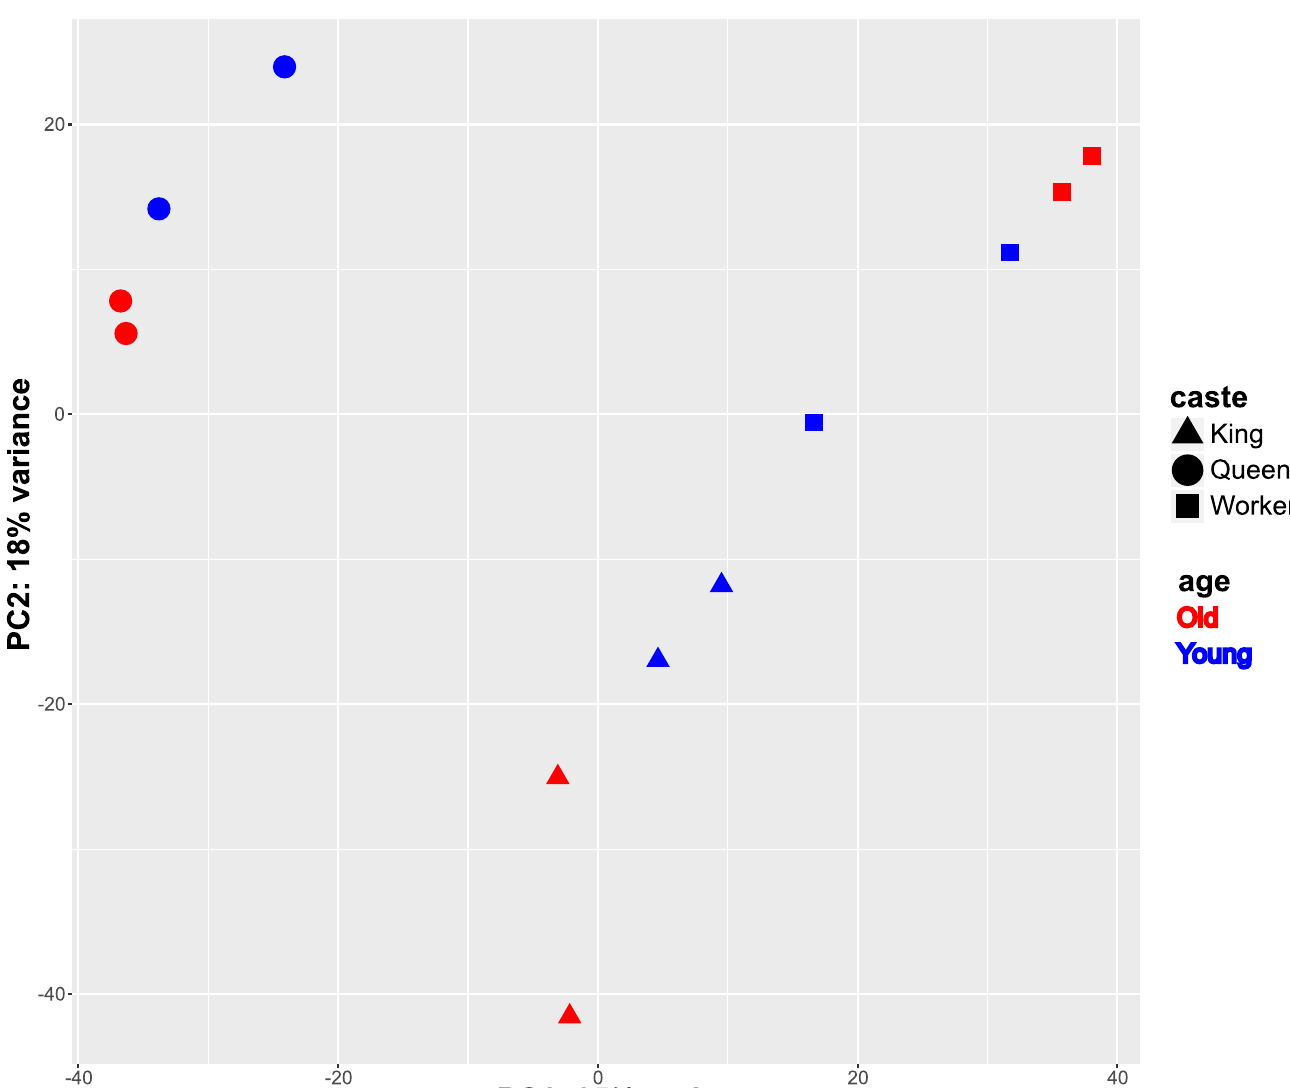
Fig 2. Principal component analysis of transcript count data. Principal component analysis of transcript count data with variance stabilizing transformation for two age classes of reproductives and workers.